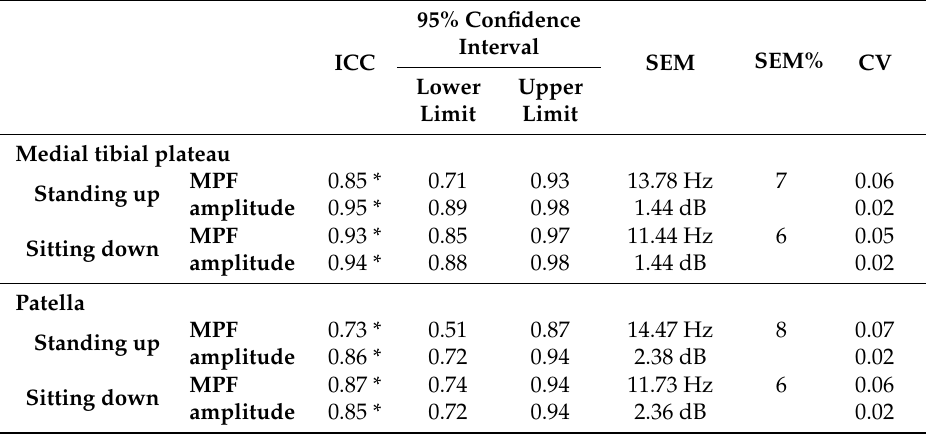
Table 1. Intrasession reliability at the medial tibial plateau and the patella for the standing up and sitting down movement 1 .